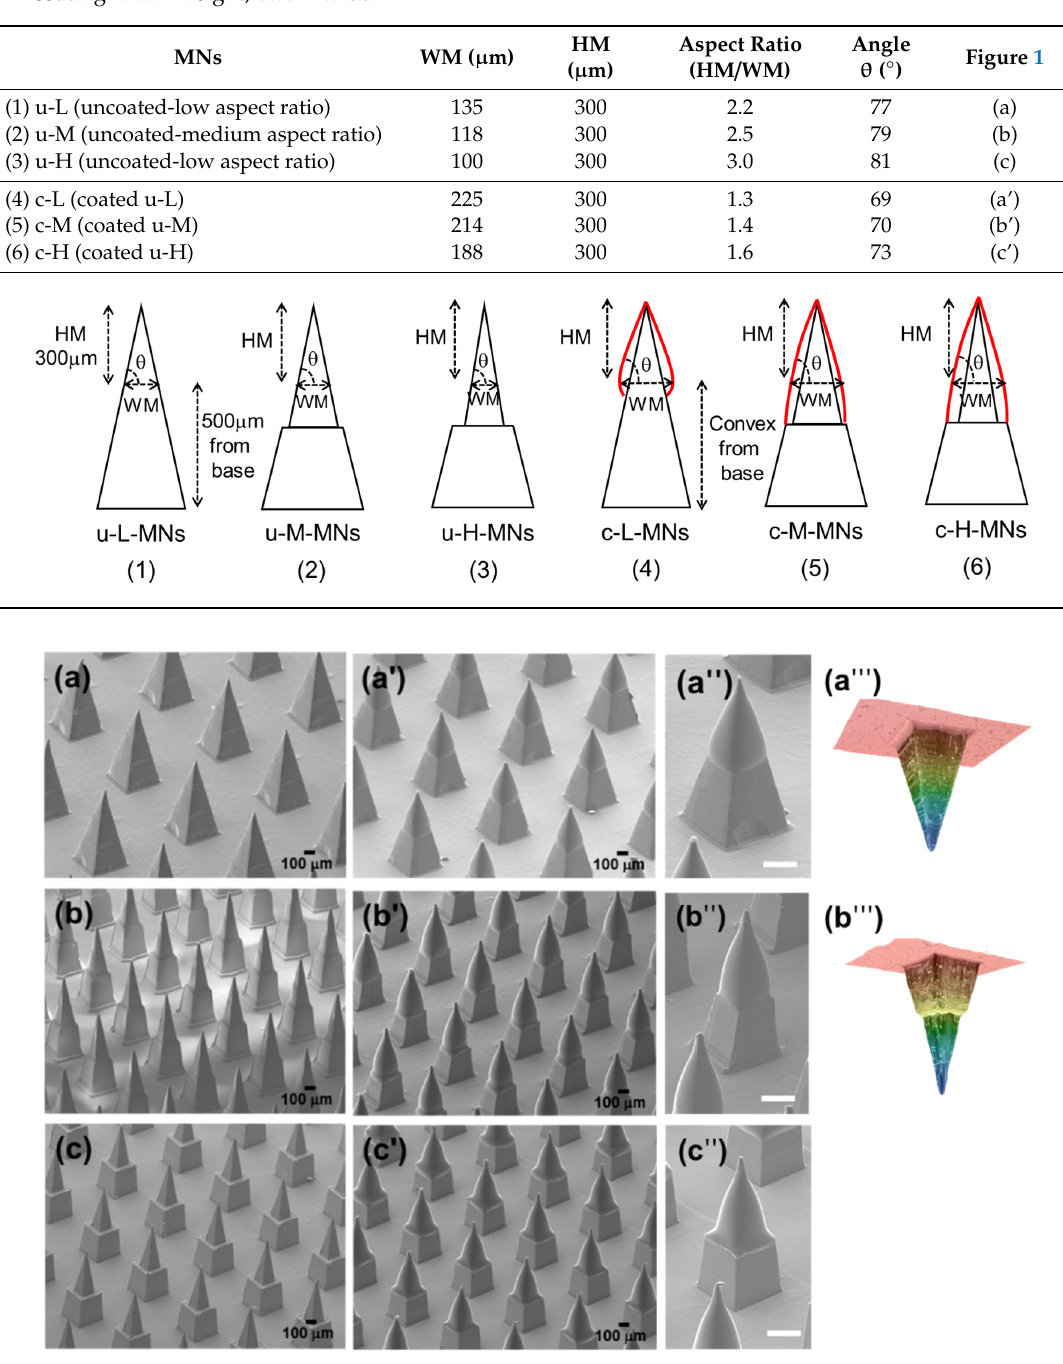
Table 2. Information on the geometries of three aspect ratio of microneedles (MNs) before and after coating. HM—height; WM—width.